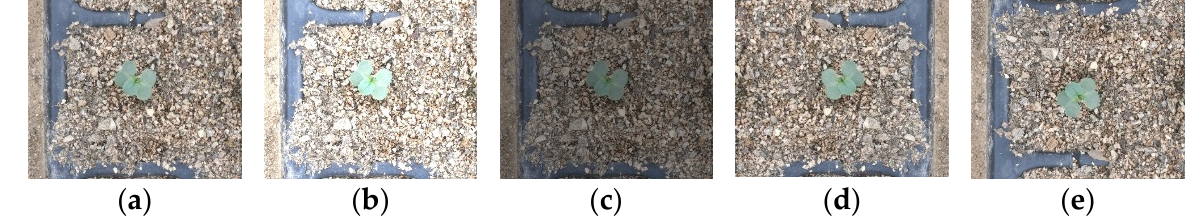
Figure 2. Wucai seedling images after data augmentation. ( a ) Original image; ( b ) brightness enhancement; ( c ) brightness reduction; ( d ) horizontal flip; ( e ) vertical flip.